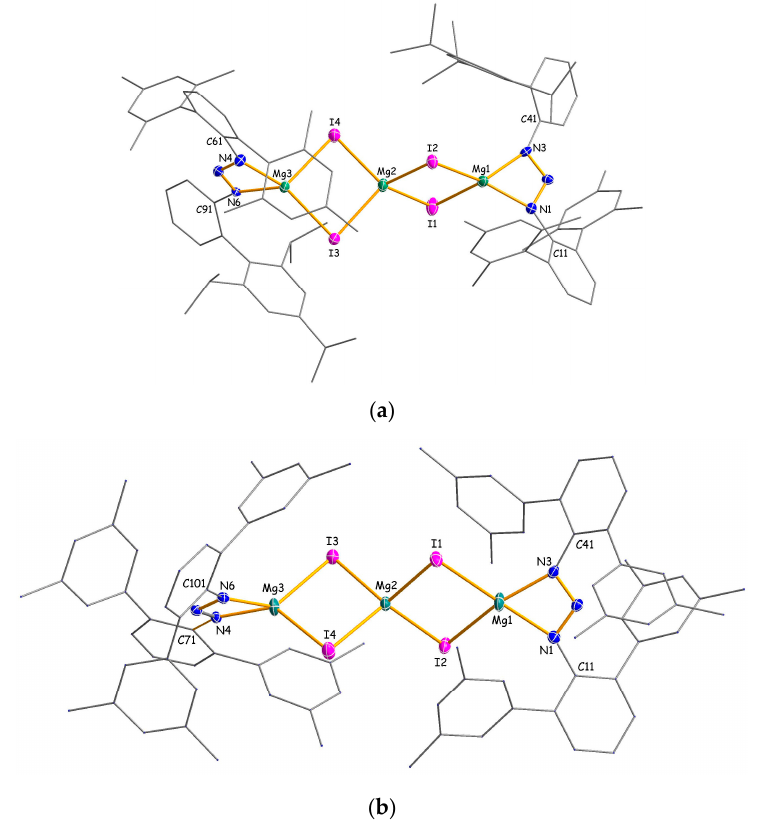
Figure 2. Molecular structures of 3a ( a ) and 3b ( b ) with thermal ellipsoids set to 30% probability. Hydrogen atoms have been omitted and carbon atoms are reduced in size for clarity. Selected bond lengths (Å)